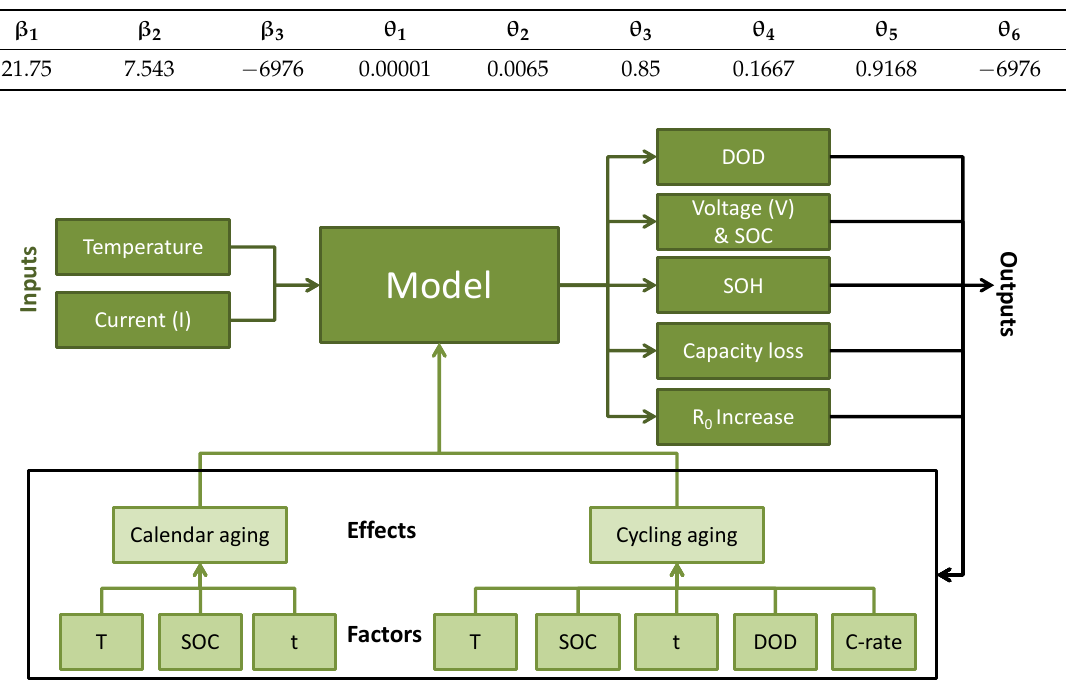
Table 1. Values of the parameters in the model.